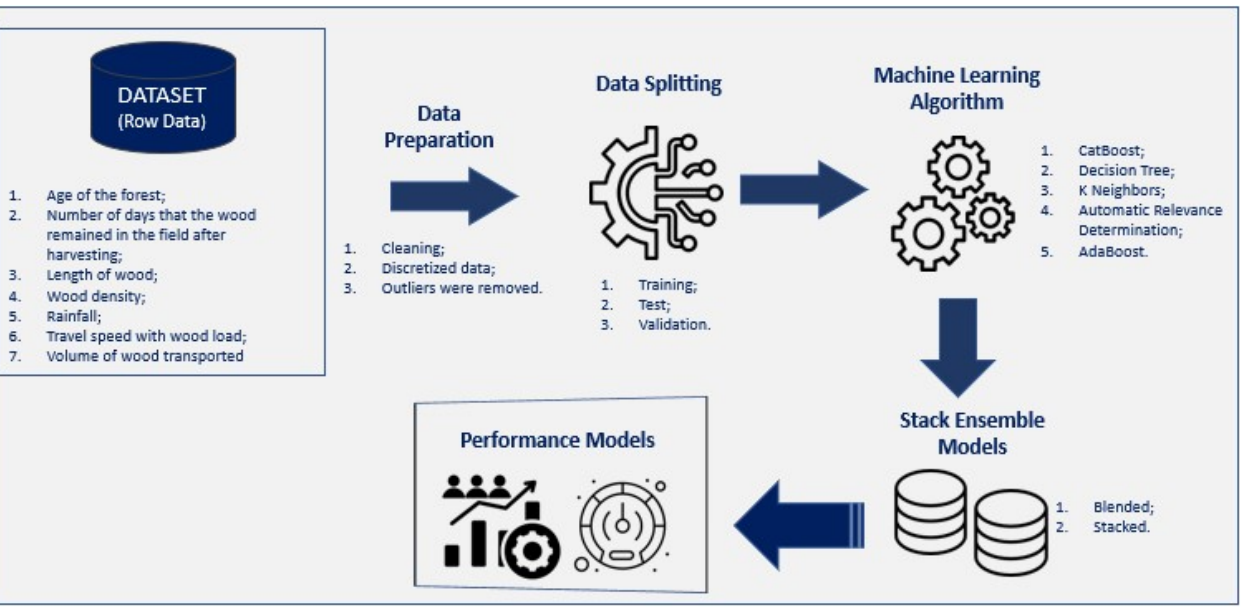
Figure 1. Data flow diagram.